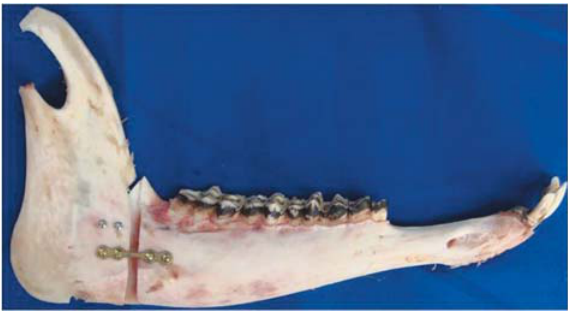
Figure 4- Hybrid group (Group II)